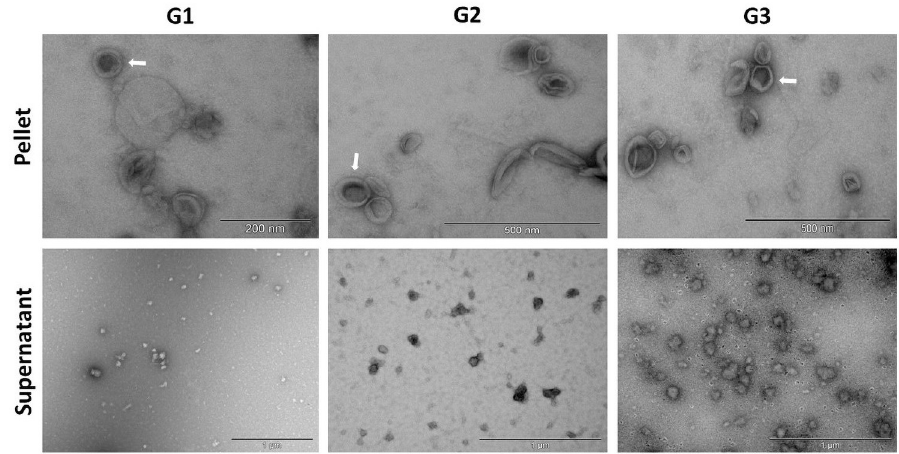
Fig 7. Morphology of bovine milk-derived exosomes isolated via differential ultracentrifugation (DUC) and visualized by Transmission Electron Microscopy (TEM). Group (G)1: whole milk frozen immediately upon collection and processed post-thaw. G2: Whole milk processed to remove fat globules and cream prior to ultracold storage. G3: Whole milk processed to remove fat globules, cream, milk cells, and casein proteins prior to ultracold storage. Scale bars: 200 nm—1000 nm.